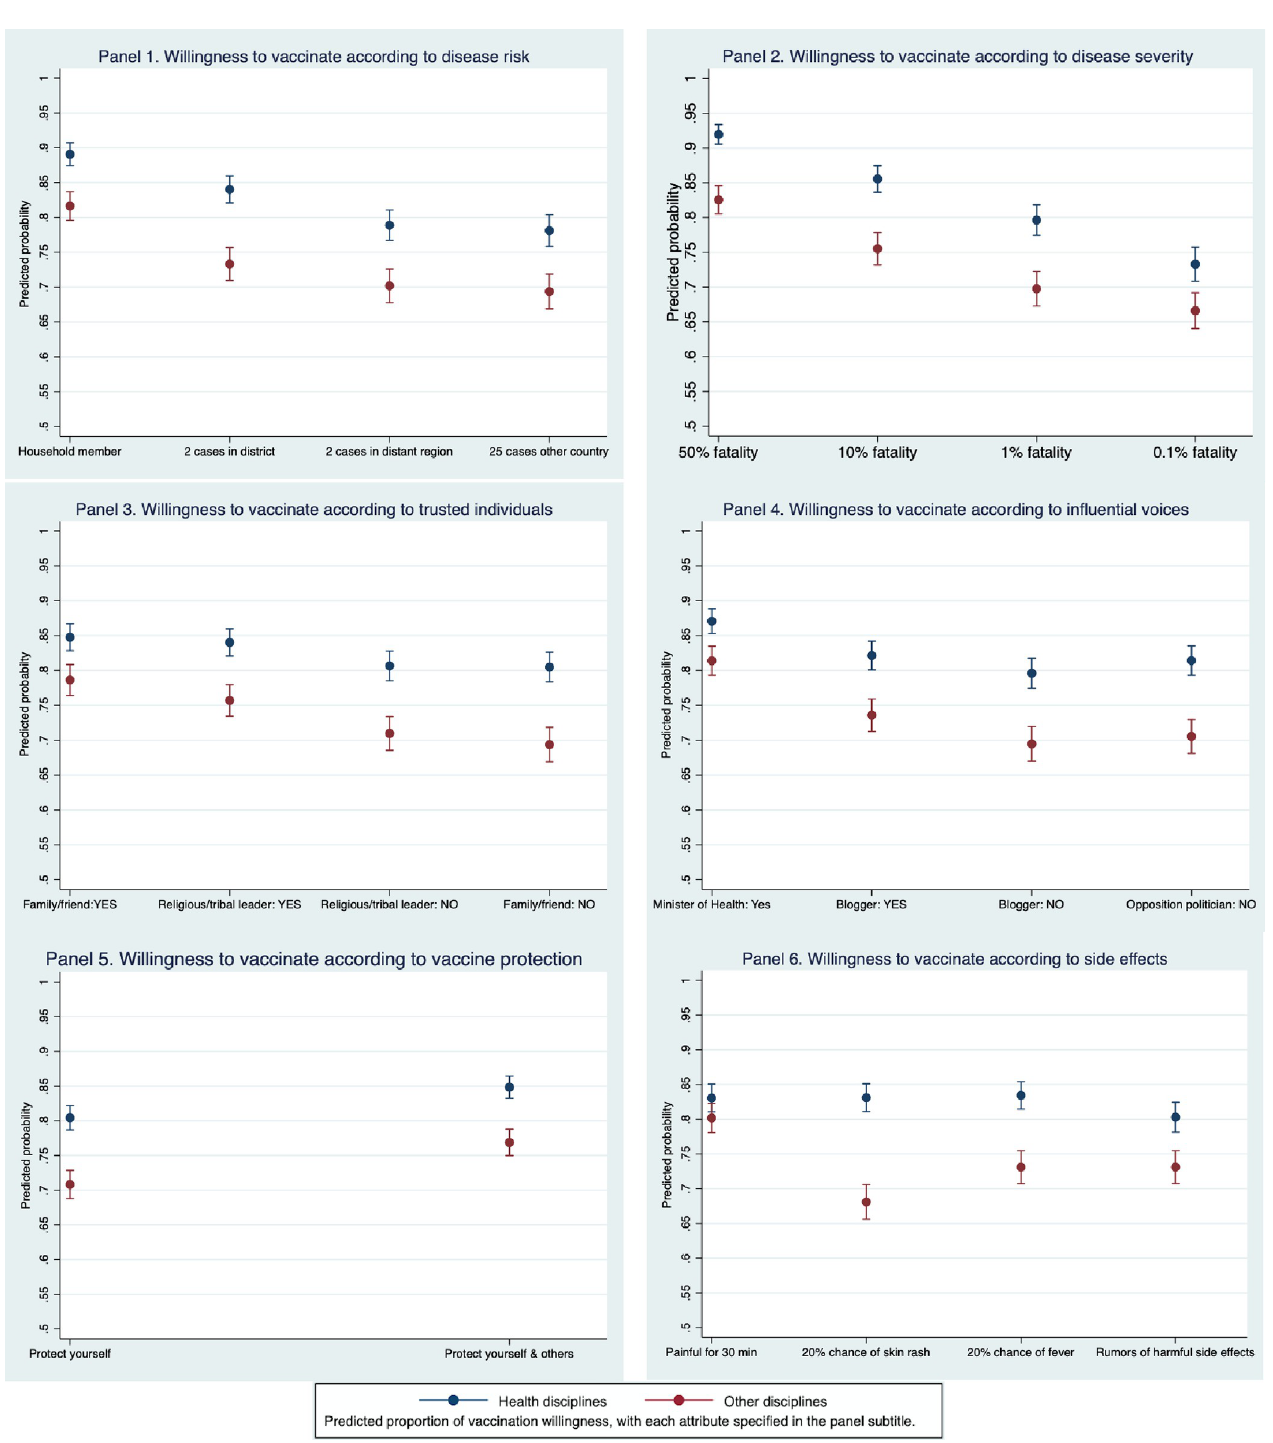
Fig 2. Predicted probability and 95% CI of vaccination willingness for in six parameters: Disease risk, disease severity, trusted individuals, influential voices, vaccine protection and side effects.